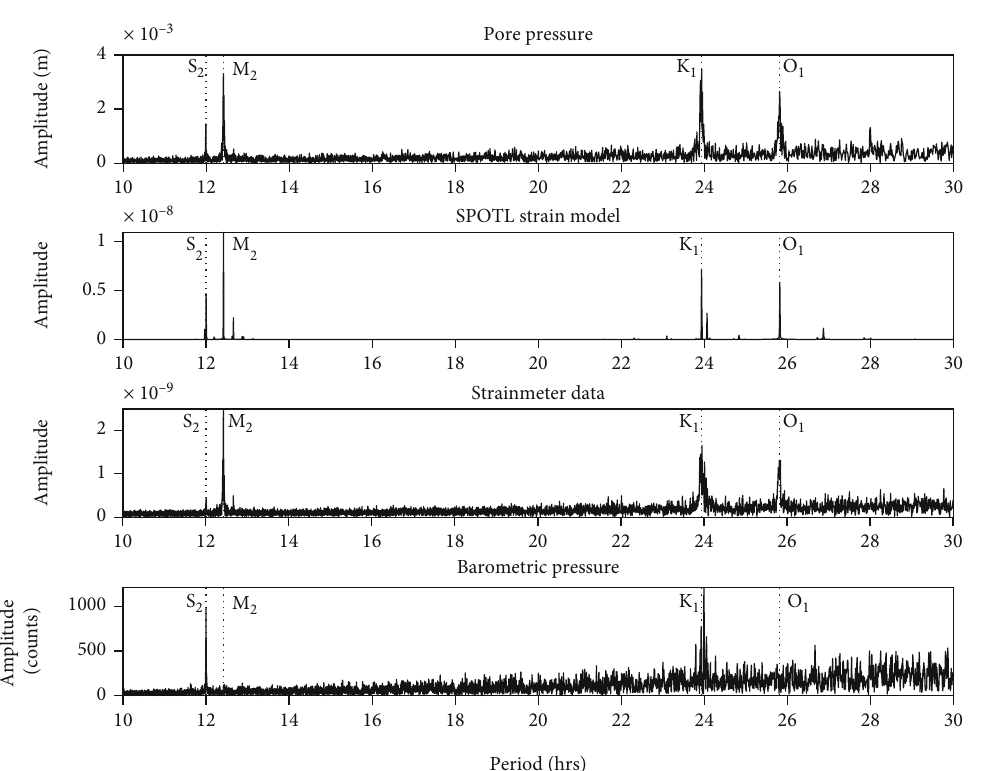
Figure 5: FFT performed on data products from observatory B001. Note the absence of the M barometric pressure